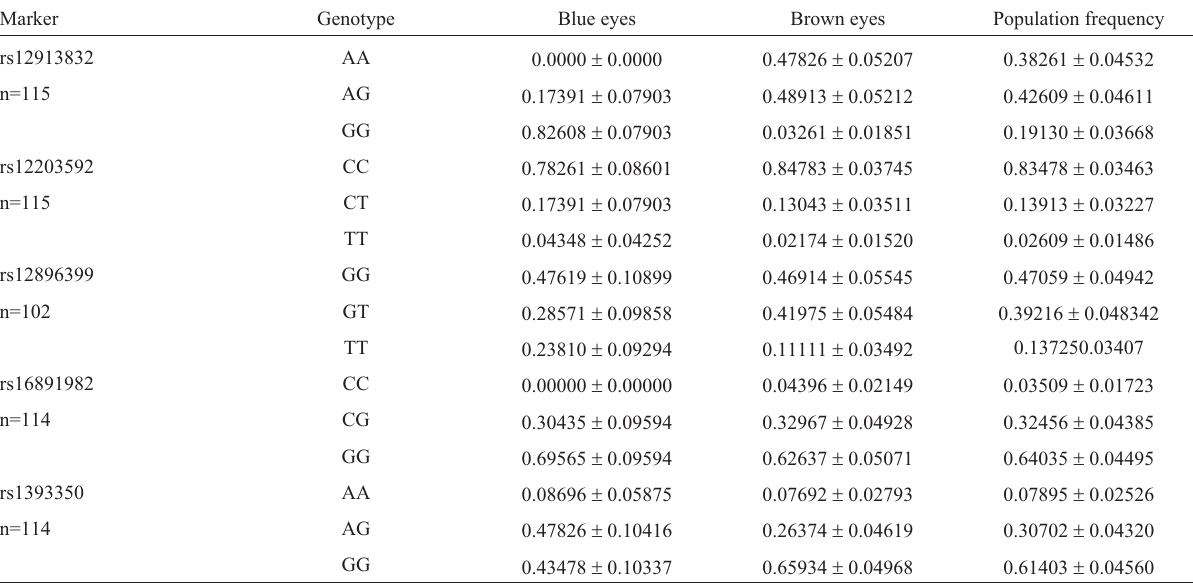
Table 1 - Genotypic frequencies for five markers related to eye color. n: sample size. Marker